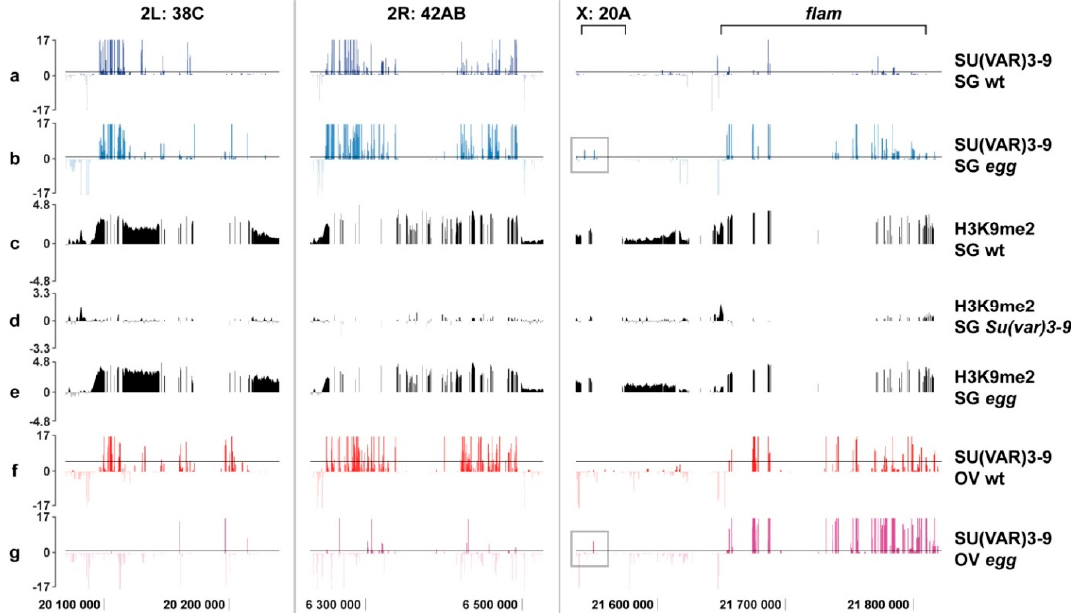
Figure 7. SU(VAR)3-9 distribution (colored profiles) across the four piRNA clusters in salivary glands (SG; a , b ) and germline cells of the juvenile ovaries (OV; f , g ) from wild type (wt) and egg mutants, as well as H3K9me2 distribution (black profiles) in the salivary glands from wild type, egg , and Su(var)3-9 mutants ( c – e ). Data for SU(VAR)3-9 SG wt are taken from [28]. H3K9me2 profiles have been retrieved from the raw data reported by [35], the rest of the profiles are obtained in the present study. Grey frames in figures ( b , g ) denote novel SU(VAR)3-9 peaks in the piRNA cluster 20A, observed in egg mutants. Y axis shows significance of SU(VAR)3-9 binding as a − log 10 scale of p -value (colored profiles) or log 2 (IP/input) value for H3K9me2 (black profiles). Genomic coordinates on the X axis correspond to the BDGP Release 6.